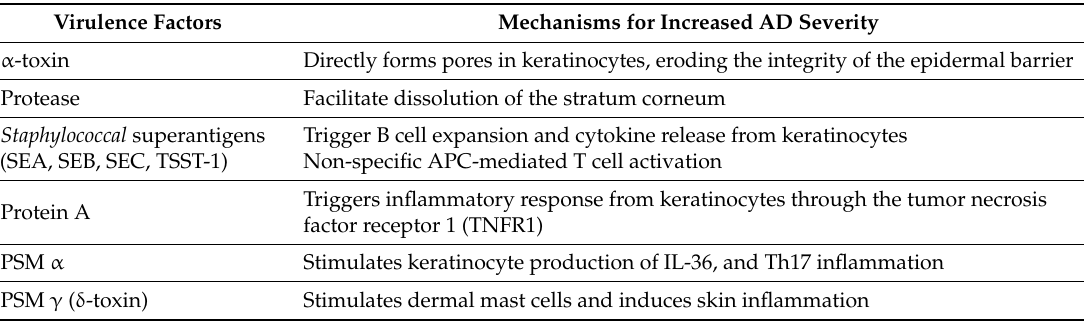
Table 3. Mechanisms of S. aureus -mediated AD